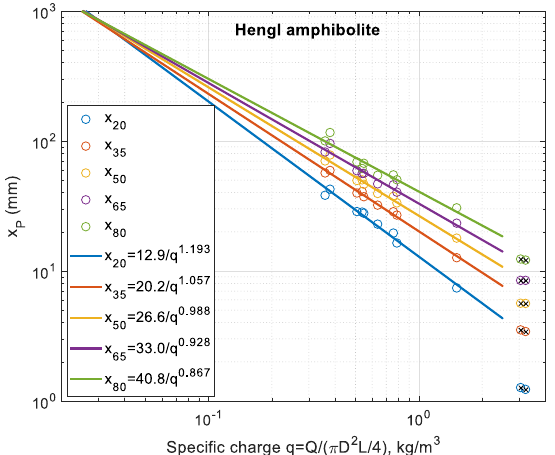
Figure 1. Fragmentation-energy fan; sieving data from blasted cylinders of Hengl amphibolite (Figure 2 in [21]) plotted as: 𝑥 𝑃 = 𝑓(𝑞) . Crossed points not included in the fits.